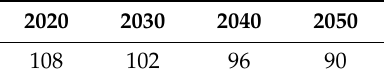
Table 6. Assumed costs of converter stations for HVDC transmission lines (unit: Mio. € )